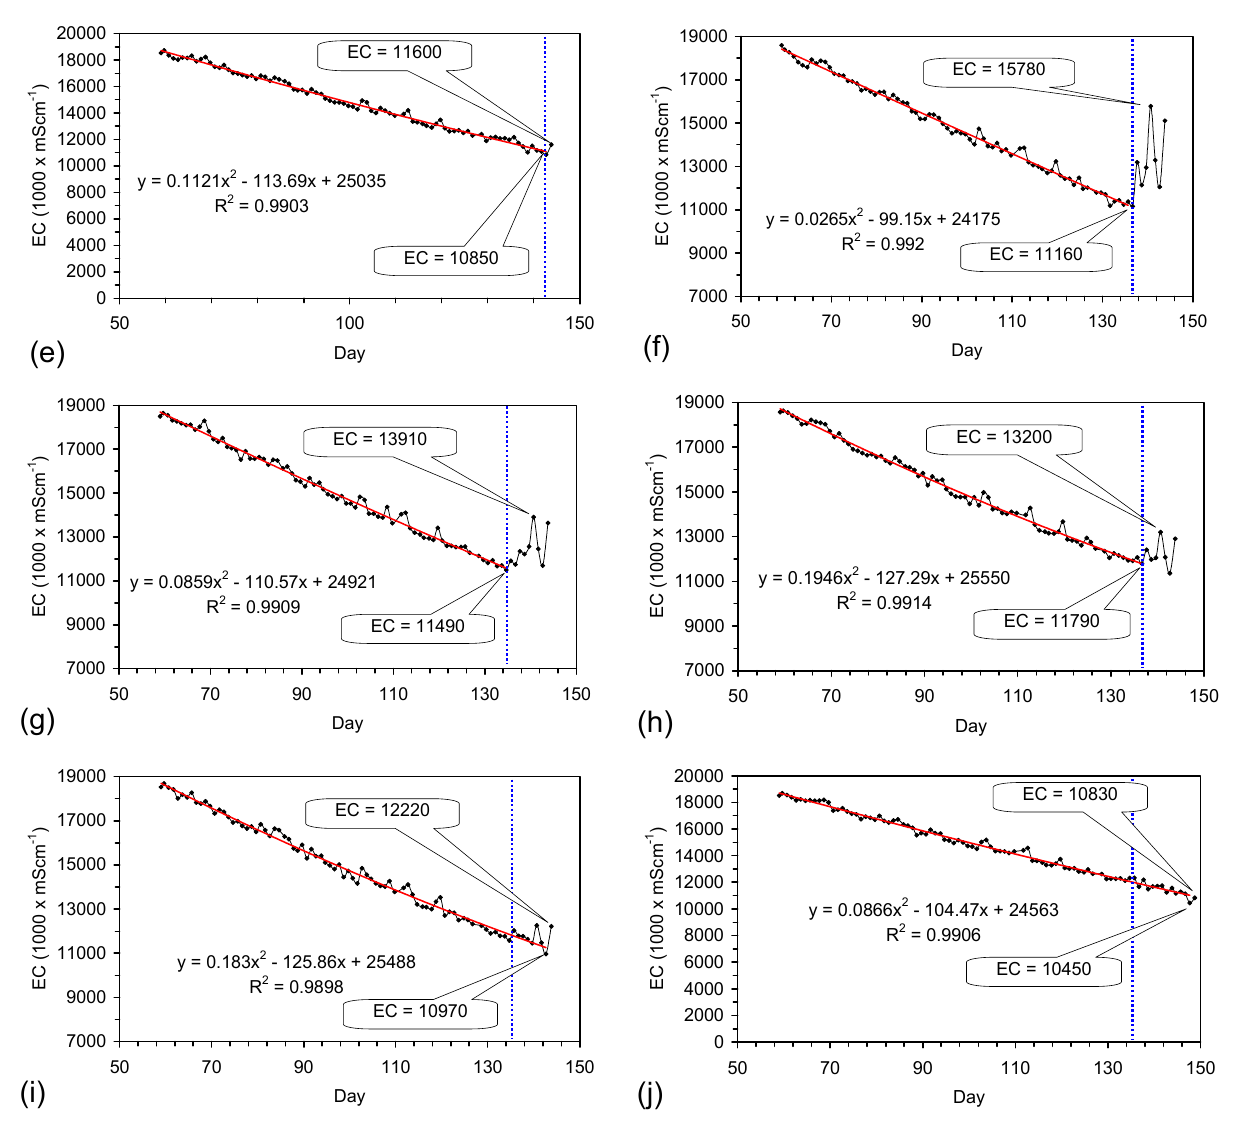
Figure D4. Feed Water EC = 18.480 mS·cm − 1 . ( a ) S3:T1; D = 0.0063; R 2 =